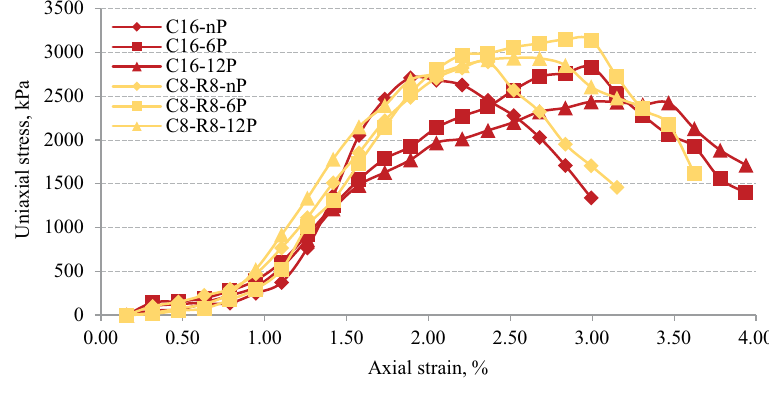
Figure 5. Uniaxial stress versus axial strain of stabilised samples and reinforced with different PP cases